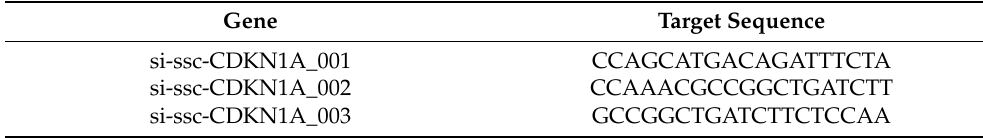
Table 3. Target sequence of the